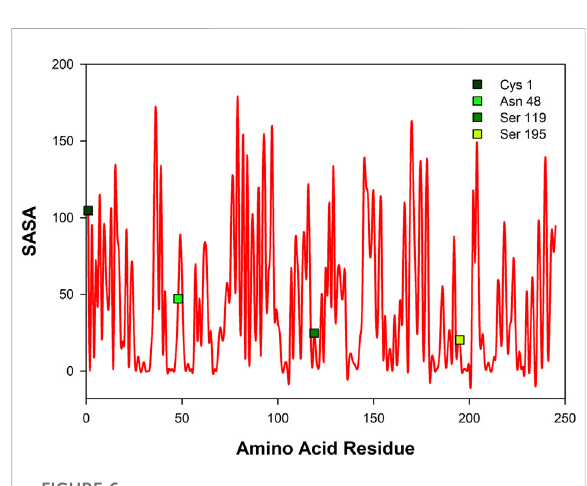
FIGURE 6 Solventaccessiblesurfacearea(SASA)ofCHT[PDBID:1CGJ]. Four different residues corresponding to the catalytic site and molecular recognition were selected [Cys-1; Asn-48; Ser-119; Ser-195] for formalin induced modi fi